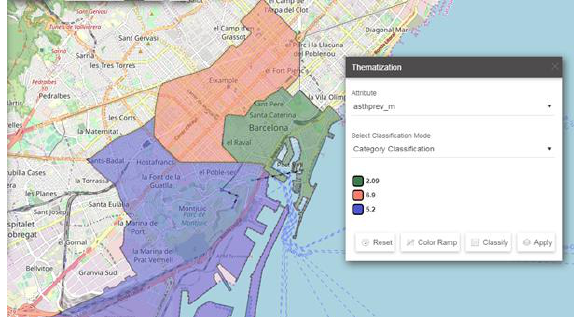
Figure 12. Thematization widget (by category)